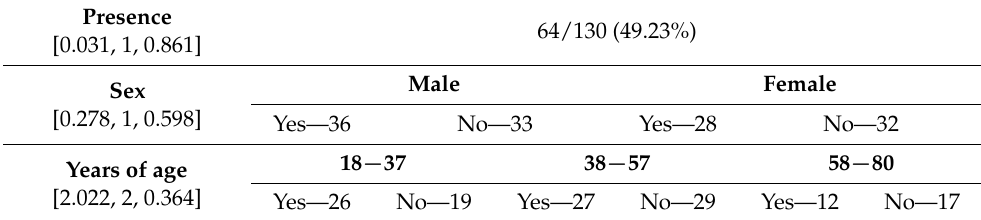
Table 1. Data for presence of accessory canal in anterior maxilla at the level of central